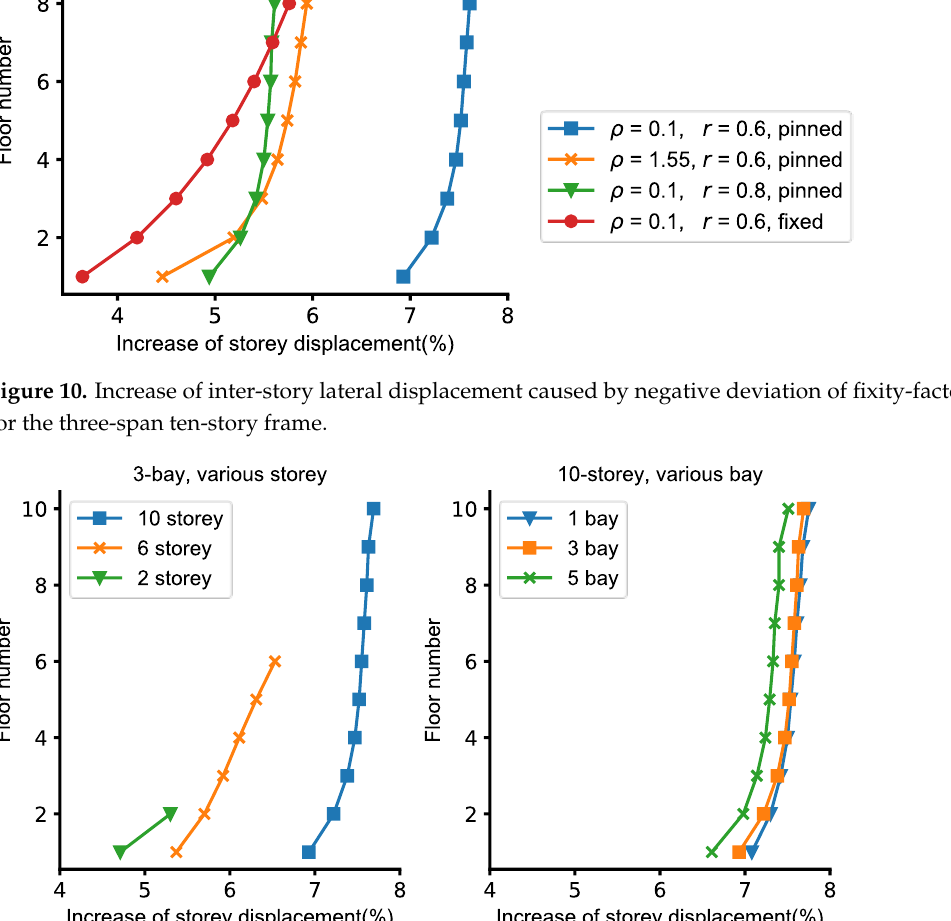
Figure 11. An increase in the inter-story lateral shift caused by the negative deviation of the fixity- factor for frames with a different total number of stories or spans. The linear stiffness ratio of the beam to column is 0.1, the fixity-factor is 0.6, and the negative deviation of the fixity-factor is 0.025; the bases are pinned.